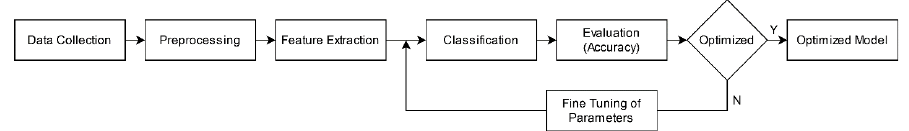
Figure 2. Process of optimizing a classification model for disease